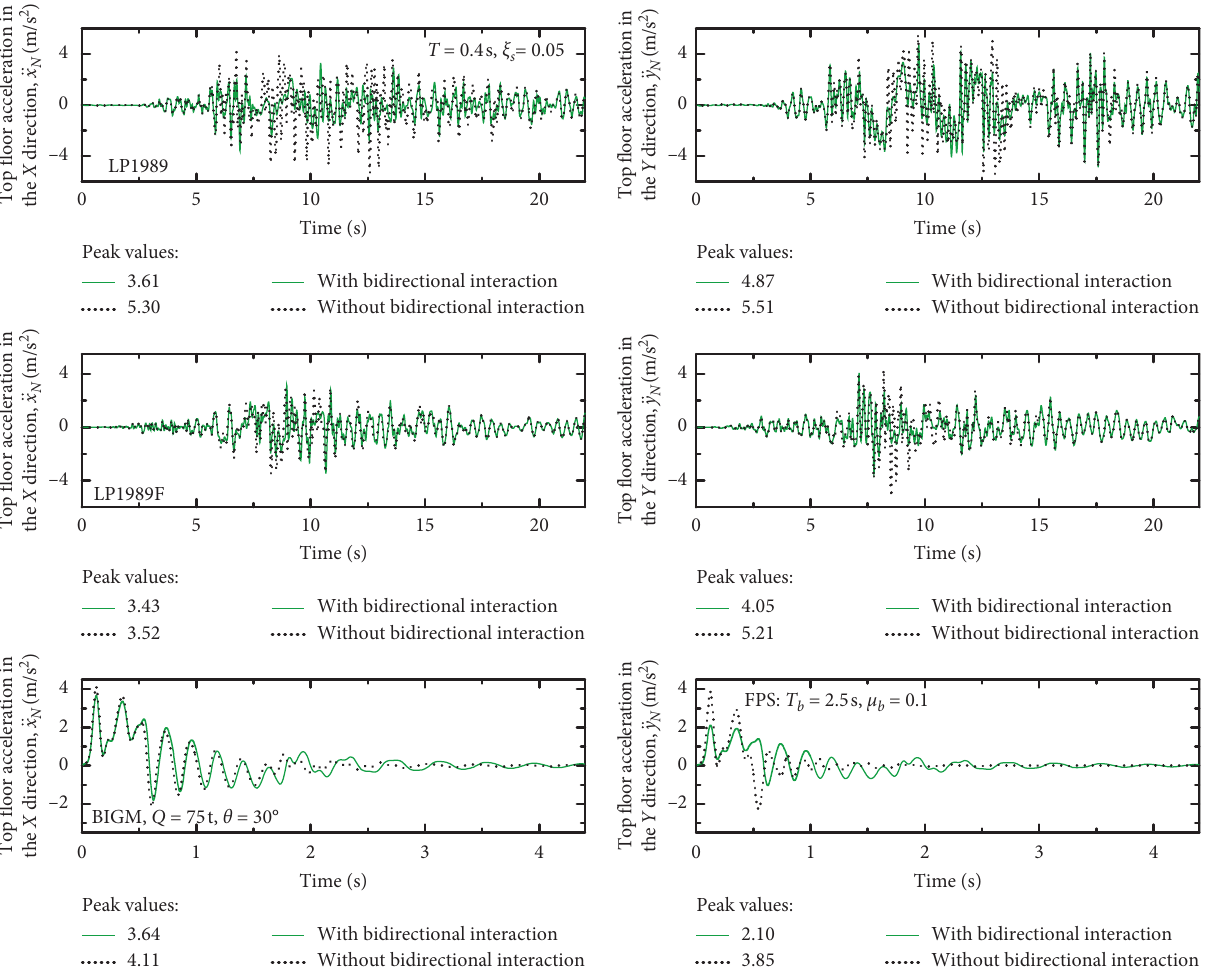
Figure 5: Top floor acceleration response history of a four-story base-isolated building with and without the consideration of bidirectional